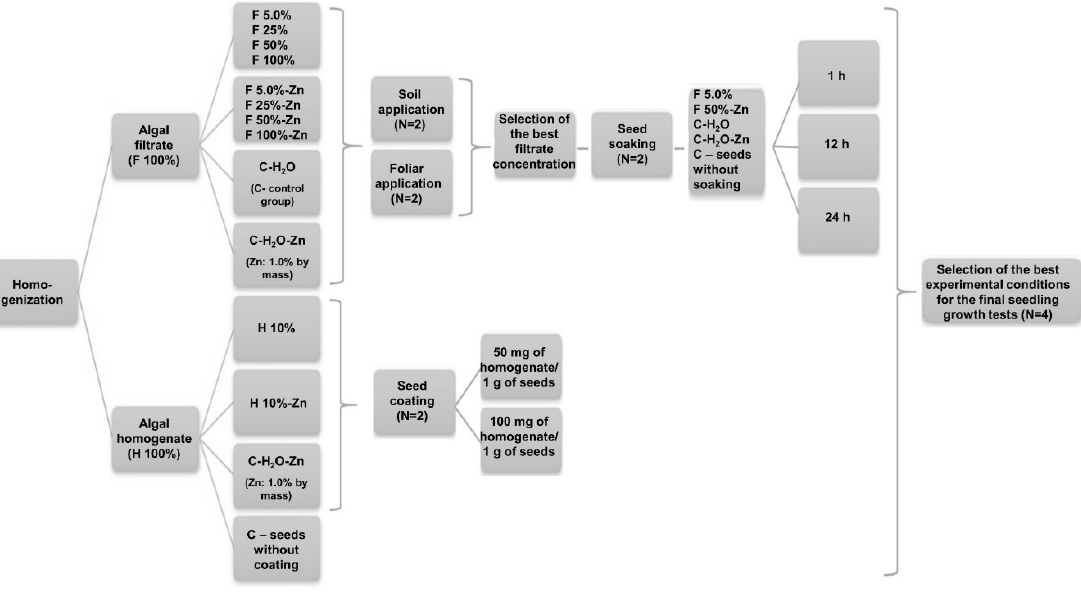
Figure 1. General scheme of the conducted experiments—selection of the best experimental conditions for the tests on radish seeds.